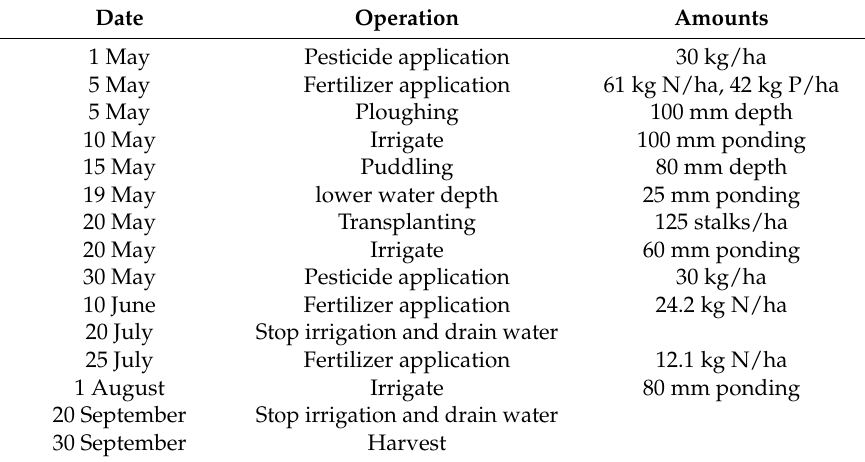
Table 1. Typical paddy management schedule of the Icheon